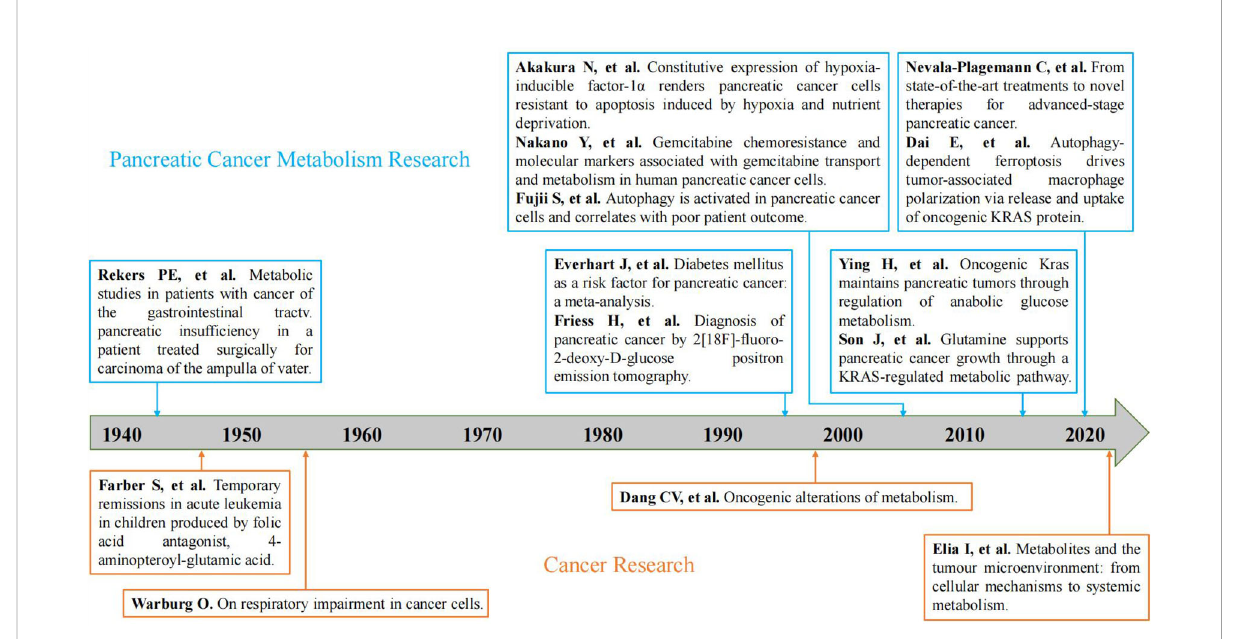
FIGURE 9 Development of representative studies of tumor metabolism and pancreatic cancer metabolism. (The blue is a representative study of pancreatic cancer metabolism; The orange is a representative study of tumor metabolism